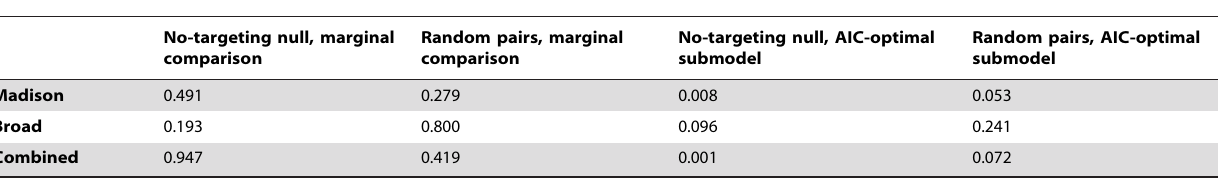
Table 2 provides p-values of the numbers of correct identifications for each of the Madison, Broad and combined datasets under no-targeting null and random pairs distributions. The number of correct identifications obtained after compensating for biological and idiosyncratic covariates is typically at least marginally significant in any of the datasets under study, using either randomization null. Marginal comparisons do not yield significant numbers of correct identifications in any of the cases under